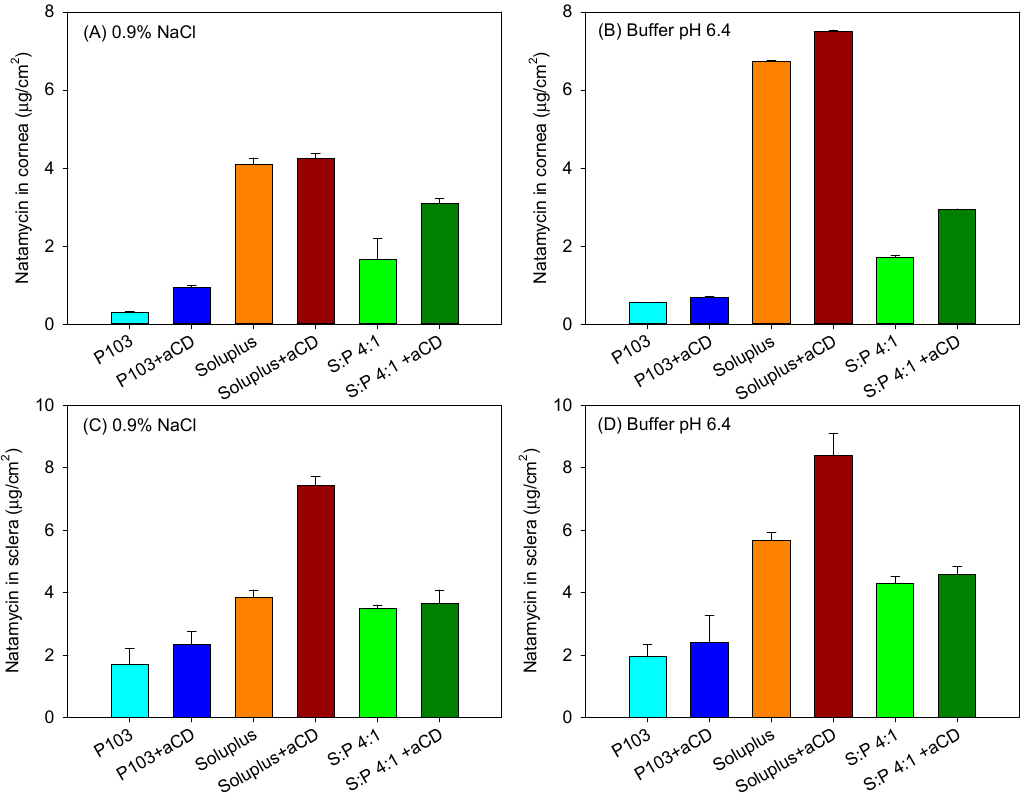
Figure 7. Amount of natamycin accumulated inside bovine cornea ( A , B ) and sclera ( C , D ) after 6 h in contact with Soluplus and Pluronic micelles, Soluplus:Pluronic P103 4:1 v / v mixed micelles, and their poly(pseudo)rotaxanes in 0.9% NaCl (left) and pH 6.4 bu ff er (right). Total copolymer concentration was 10% w / v in all cases.